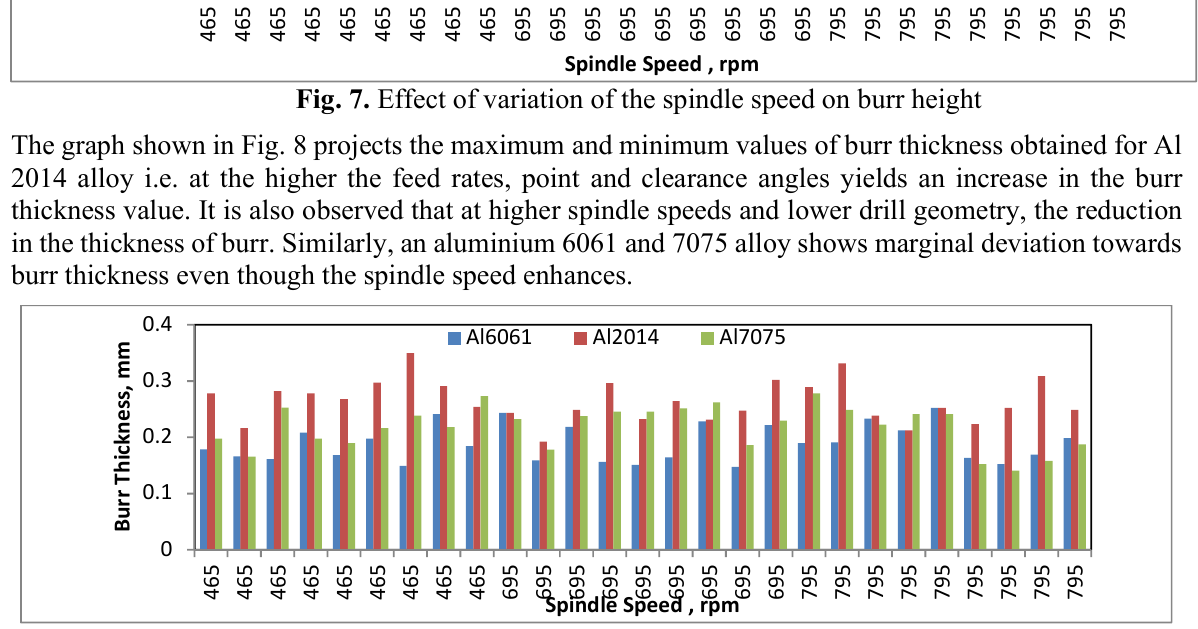
Fig. 8. Persuade of the spindle speed variation on burr thickness